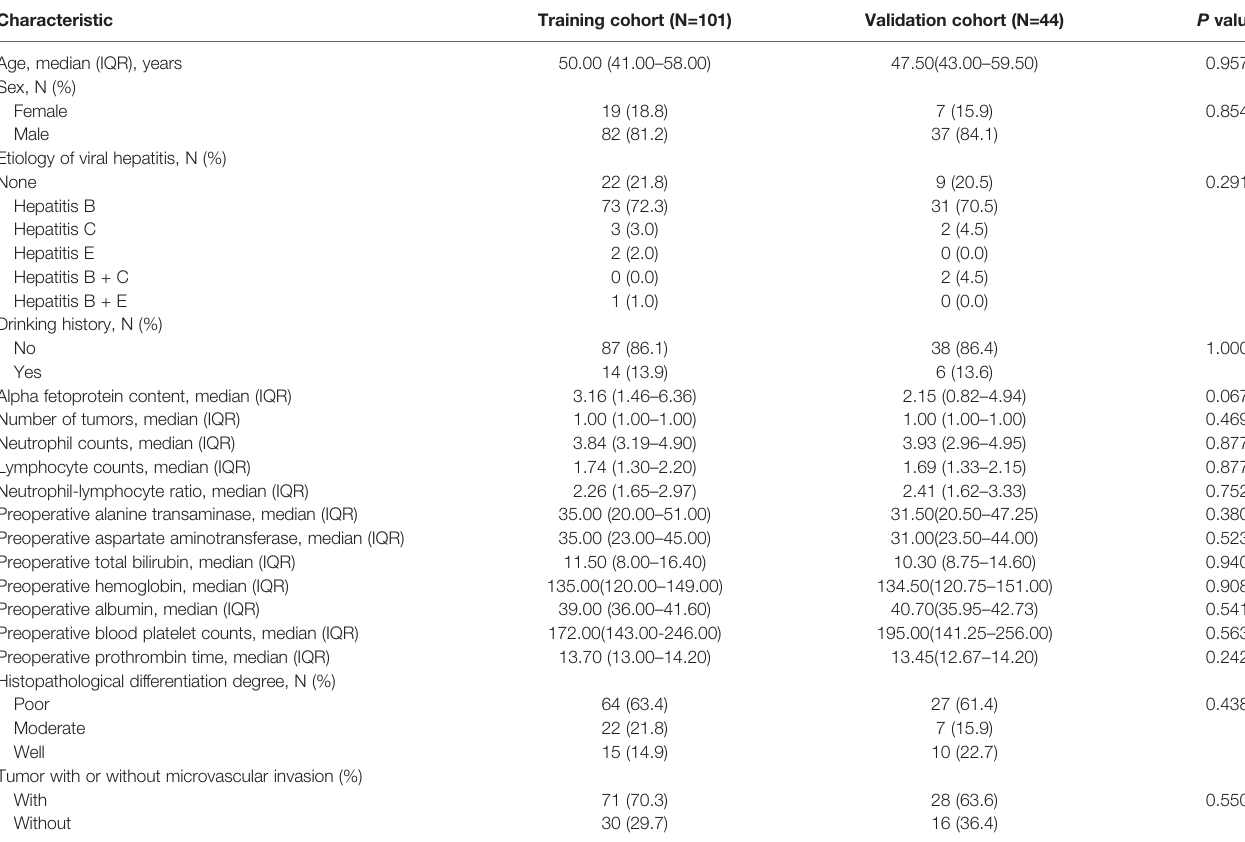
TABLE 1 | Demographic and clinicopathologic characteristics of the study